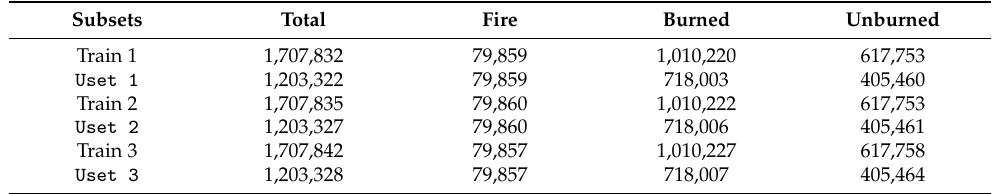
Table A1. Number of data points in total (total) and per class in the train subsets and Usets ( Fire , Burned , and Unburned